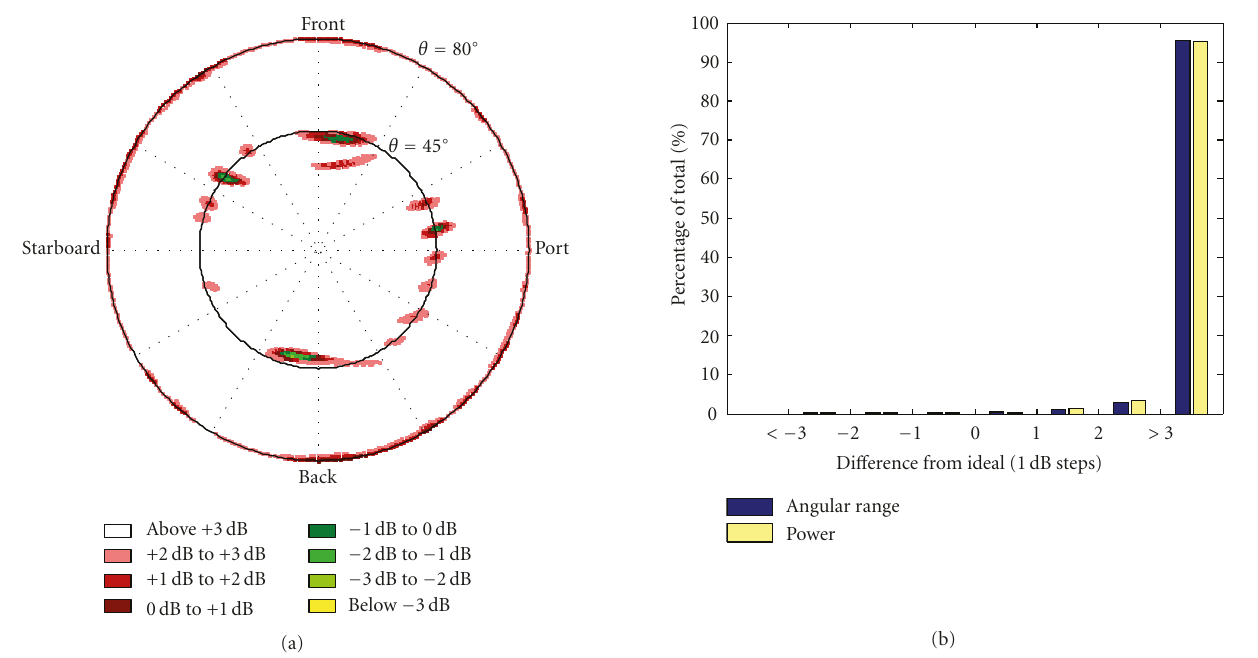
Figure 12: Assessment of helical antenna radiation pattern on the gondola with ground handling bars removed, normalised to θ = 80 ◦ minima; (a) flattened hemisphere plot of gain comparison to ideal radiation pattern shape, (b) radiation pattern power distribution in relation to ideal radiation pattern shape, from